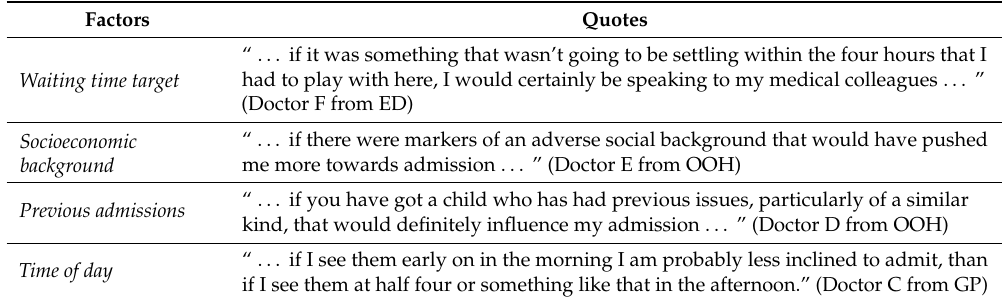
Table 2. Quotes from referring clinicians relating to some of the factors which may influence their decision to refer a child to hospital with an acute medical